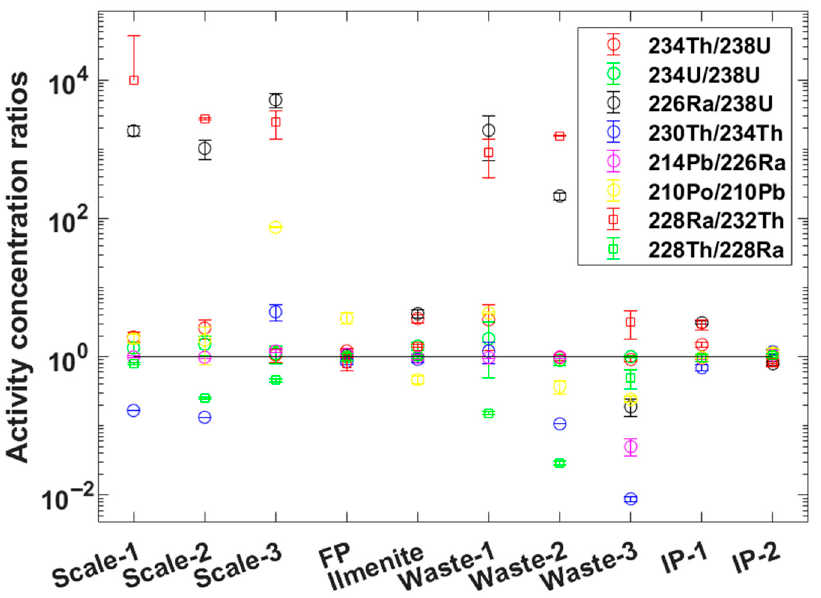
Figure 3. Activity concentration ratios for the radionuclides present in each mining sample analyzed in this work, where the ratios selected to study the secular disequilibria between the radionuclides belonging to the 238 U and 232 Th series were: 234 Th/ 238 U, 234 U/ 238 U, 226 Ra/ 238 U, 230 Th/ 234 Th, 214 Pb/ 226 Ra, 210 Po/ 210 Pb, 228 Ra/ 232 Th, and 228 Th/ 228